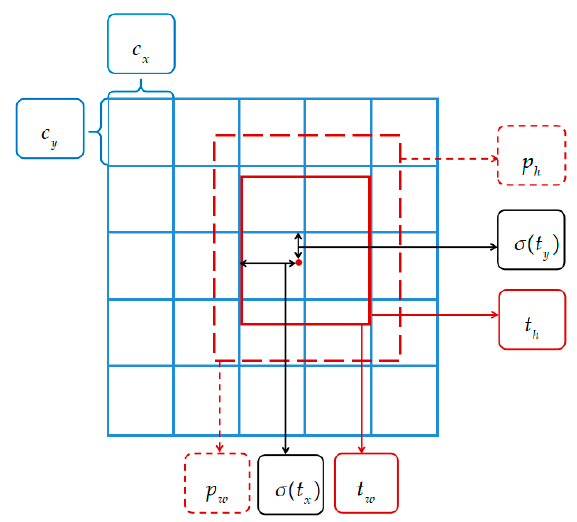
Figure 3. The final prediction.